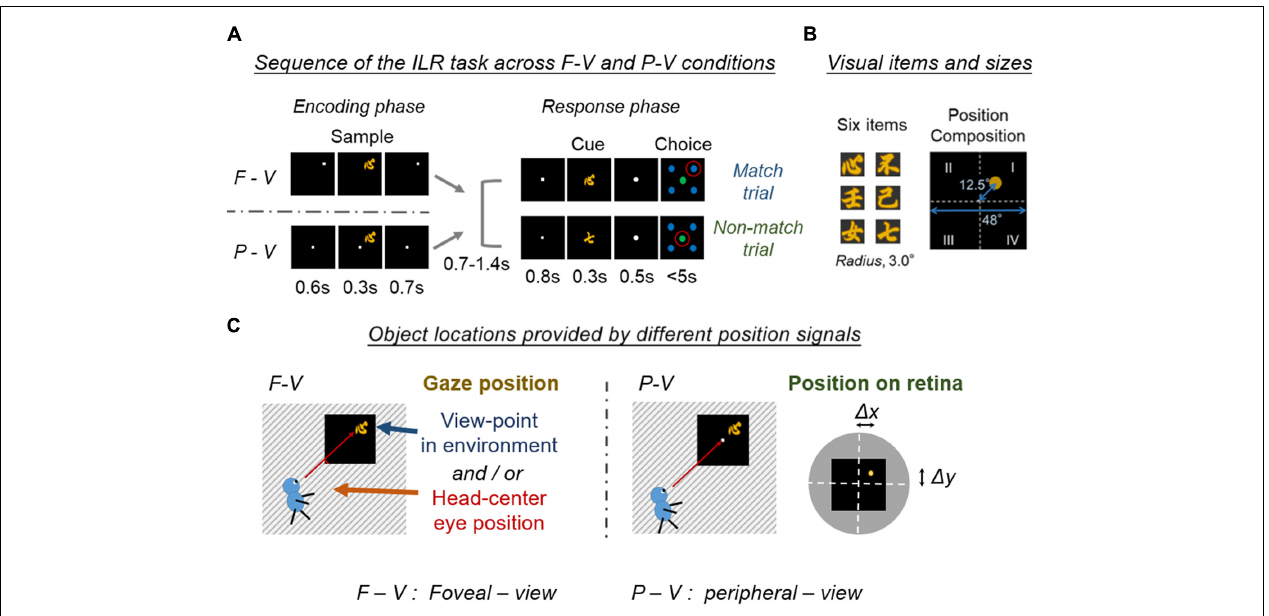
FIGURE 2 | Encoding of the location and item in the two viewing conditions. (A) Schematic diagram of the location and item encoding the F-V and P-V conditions of the ILR task. The cue stimulus was the same as the sample stimulus in the match trial (Top), while the two stimuli differed in the non-match trial (Bottom). Red circles indicate the correct answers. Adapted with permission from Chen and Naya (2020b). F-V, foveal-view; P-V, peripheral-view; ILR, item-location-retention. (B) Six visual item stimuli, and a spatial composition during the sample period. Adapted with permission from Chen and Naya (2020a). (C) Object locations provided by different position signals between the F-V and P-V conditions. The task screen is indicated by a black square and the surrounding environment is indicated by a stripe. The object location was provided by the gaze position in the F-V condition, while the object location was provided by the retinal position in the P-V condition. Note that the gaze position in the F-V condition can be defined by either the eye position in the head-center coordinate or the viewpoint in the environment. The object position on the retina could be defined as a shift from the center of the fovea ( (cid:49) x, (cid:49) y). White dashed lines indicate the horizontal and vertical meridians of the visual field. The yellow dot indicates the center of the sample stimulus. Black square indicates the task screen. The gray disk indicates the surrounding environment in the visual